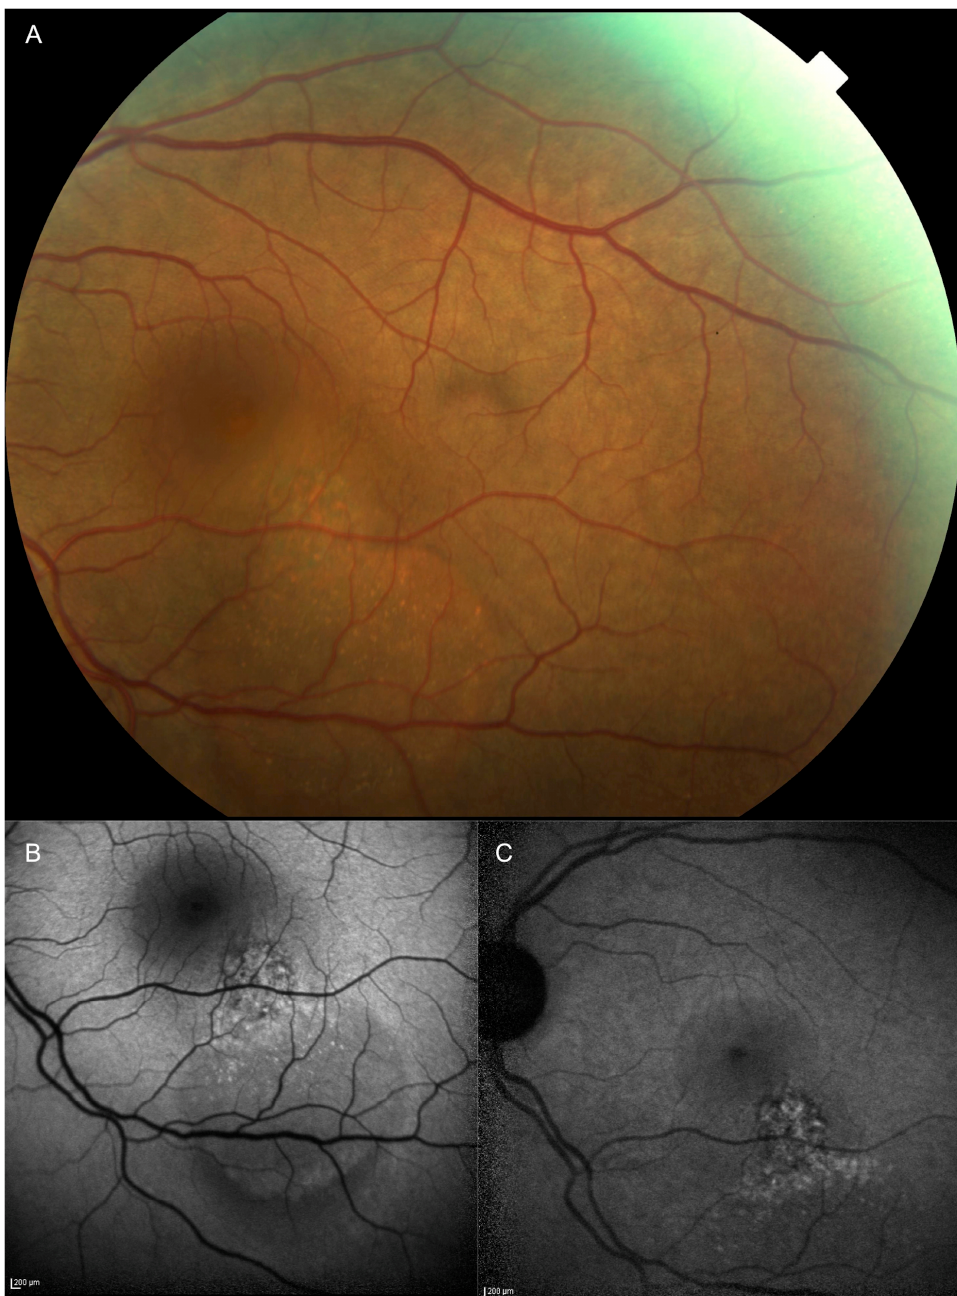
Figure 1. ( A ) Fundus photograph and ( B ) blue ( C ) and infrared autofluorescence of a case of a macular small uveal melanoma characterized by ( A – C ) diffuse orange pigment on its surface and ( B , C ) serous retinal detachment. The thickness of this lesion measured by spectral domain optical coherence tomography was 550 μ m. The current management of small choroidal indeterminate pigmented lesions (encompassing atypical nevi as well as small melanomas) is either a periodical observation until growth or treatment, whereas clinical oncology practice often considers an earlier diagnosis (and treatment) as a first and mandatory step to improve patient survival [3]. Moreover, to biopsy an intraocular malignant tumor